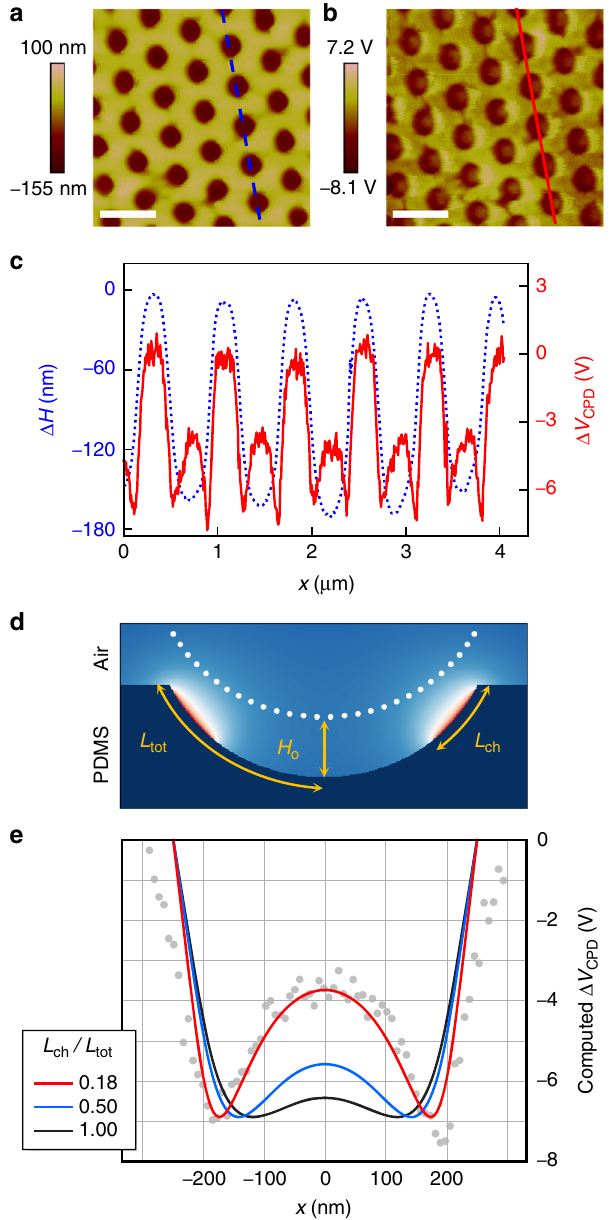
Fig. 2 SKPM-based imaging and analysis of tribocharge distribution. a AFM image of the PDMS nanocup array ’ s surface topography. b SKPM image of the surface potential V CPD at the same spot. (Scale bars: 1 μ m) c Superimposed cross-sectional pro fi les of the surface topography and potential along the scan lines in a , b . The pattern overlap clearly indicates that the inner cavity of the nanocup is negatively charged. d A schematic diagram of the surface potential computation setup. L tot and L ch represent the arc lengths measured from the nanocup ’ s rim to the bottom and the end point of the surface charge distribution, respectively. H o is the vertical gap maintained between the probe tips and the PDMS surface. The white dots represent the probing points for the surface potential measurement and evaluation. e The computed surface potentials for different charge distributions. They clearly show that the center peak rises within the potential well as the charge distribution becomes concentrated around the rim. In contrast, a dome charge ( L ch = L tot ) produces negligible center peak. The gray dots represent the experimental data in c within the 1.2 μ m < x <1.8 μ m